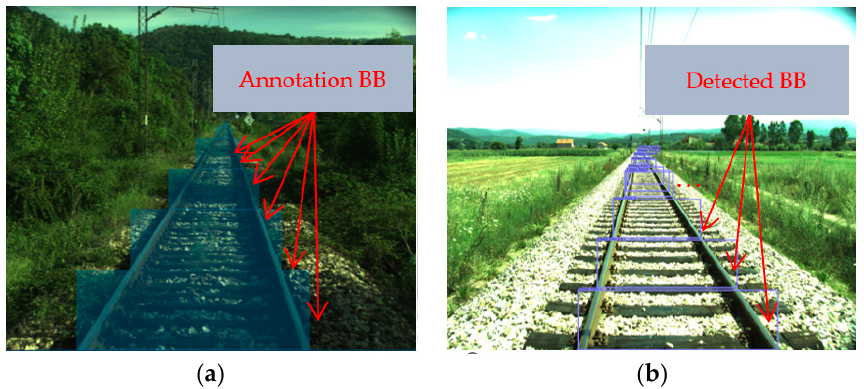
Figure 3. ( a ) Annotation of rail tracks with multiple bounding boxes (BB) along the visible length of the rail track. ( b ) CenterNet detection result of detected rail track parts as marked with purple bounding boxes.